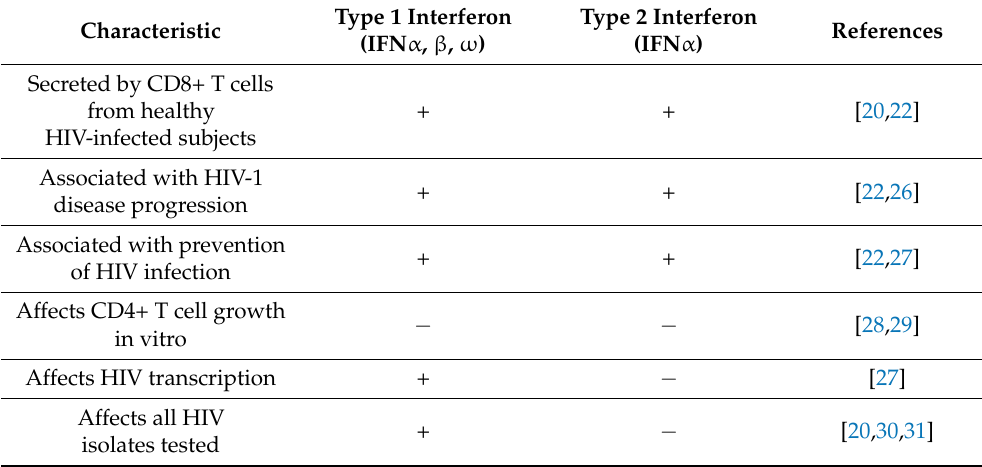
Table 1. Comparison of salient HIV-associated characteristics of type 1 and type 2